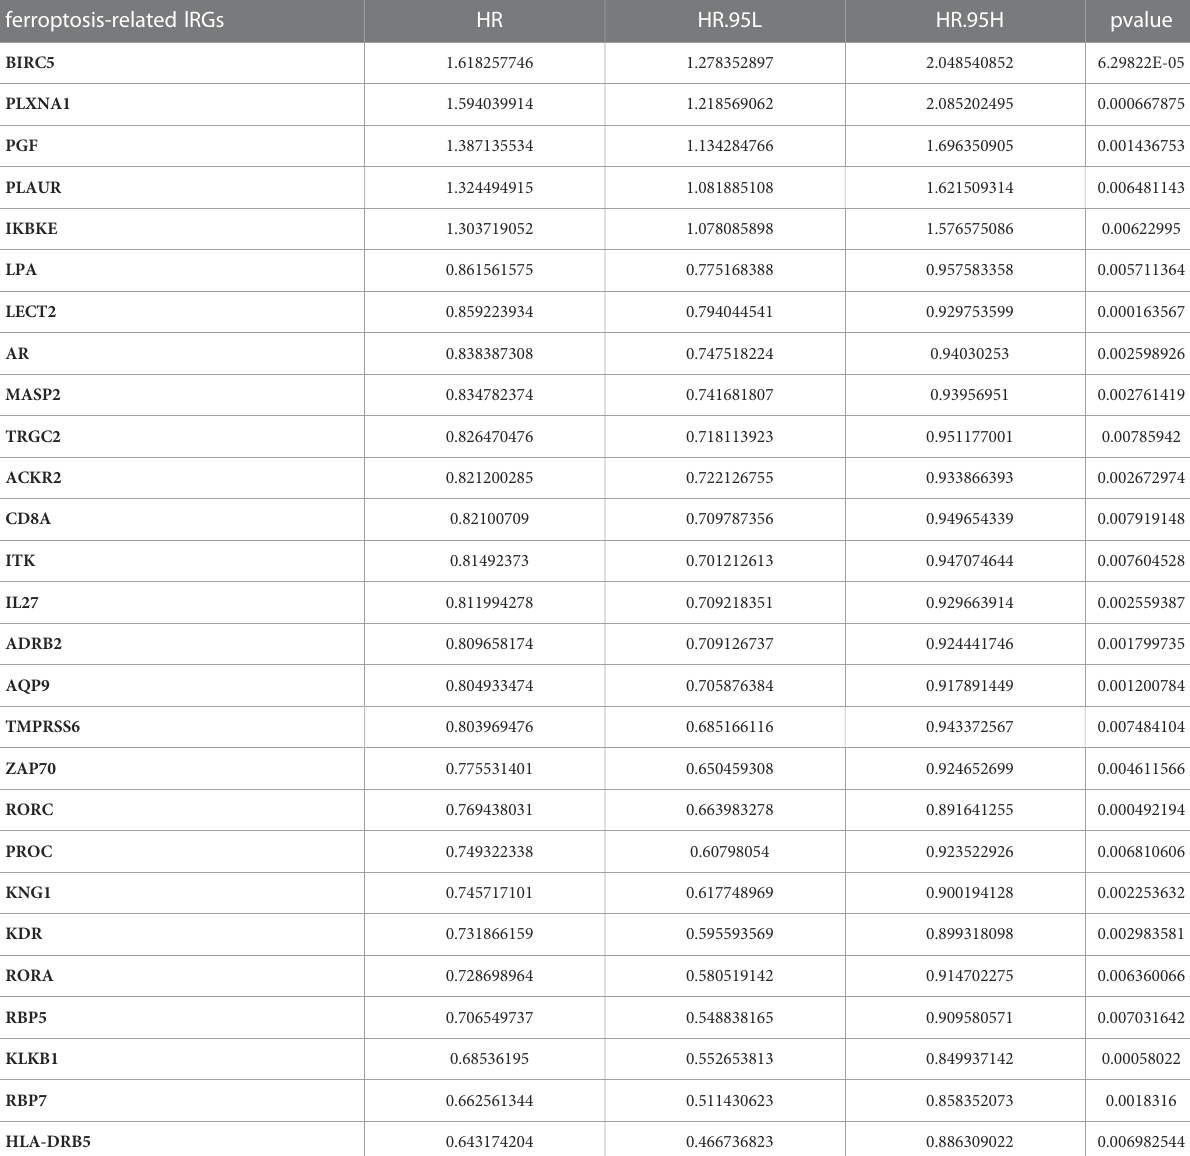
TABLE 3 The twenty-seven ferroptosis-related prognostic